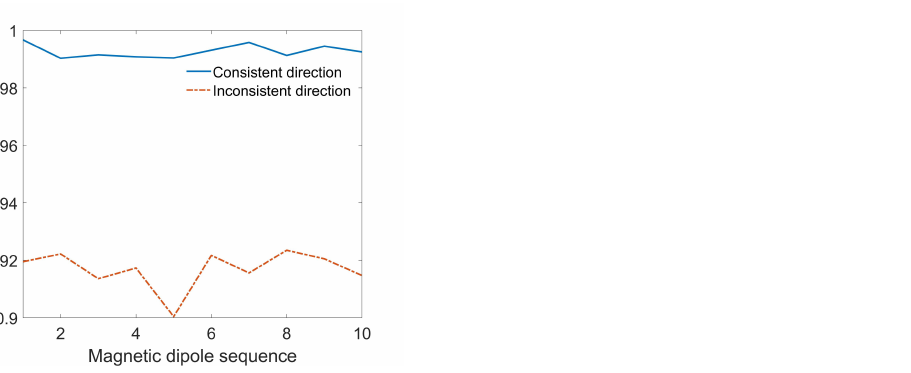
Figure 3. Equivalent consistency of two magnetic dipoles with the same and different directions of magnetic